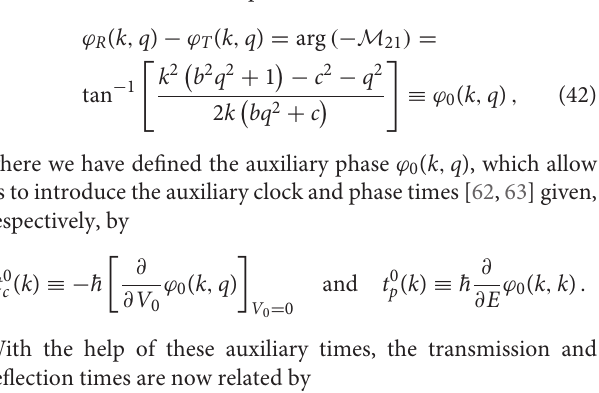
0.0075 and k 0.6 (in atomic Rydberg units). (B) Detail, for the same = =